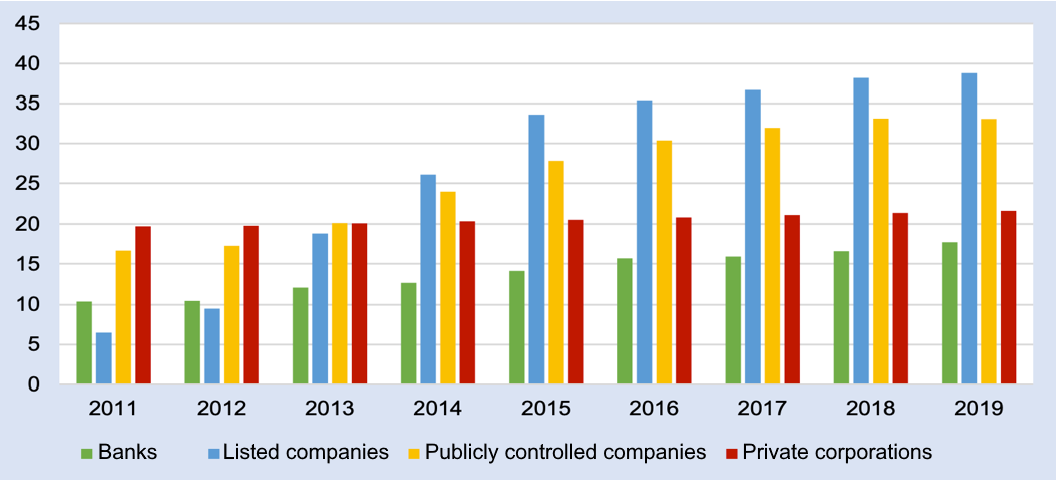
Figure 2. Proportion of Women in Control Bodies